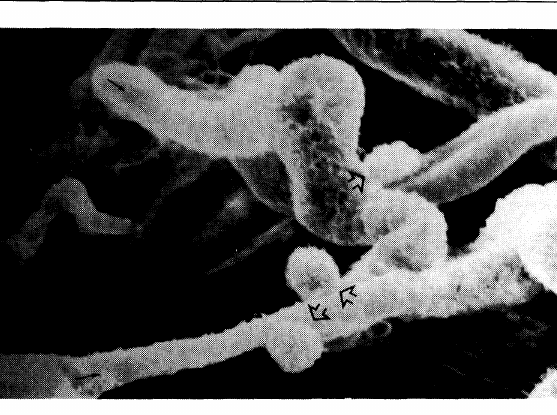
FIG. 4.90 after ZAP exposure. Intravascular leucocytes as arrowed have been chemotactically activated and are migrating through endothelial gaps out of the capillaries.